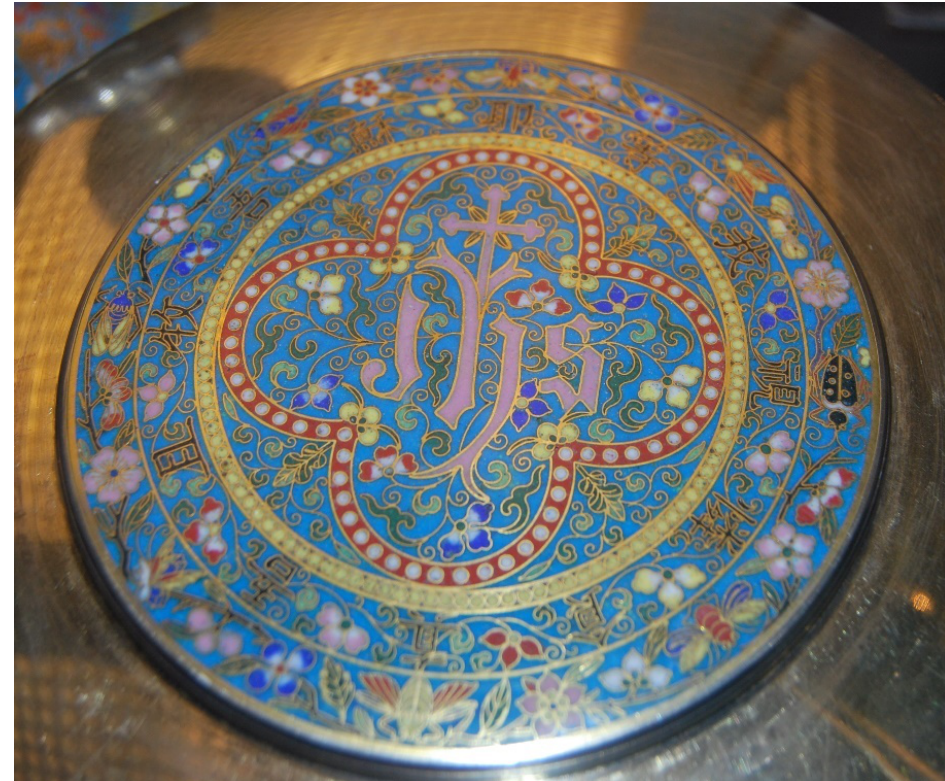
Figure 8. Paten (detail of the upper side) of Figure 3, with the Psalm 23: 1 inscribed. Photo: Manuel Parada.